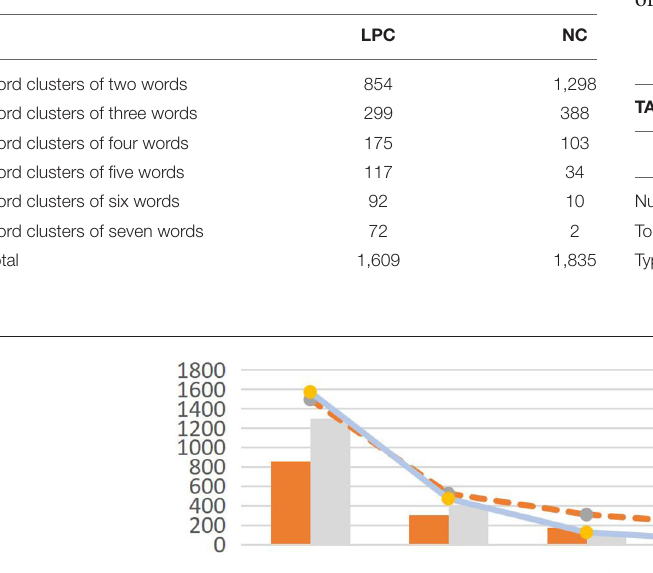
TABLE 7 | Word clusters information of 2 to 7 words with frequencies over 10 in two corpora.